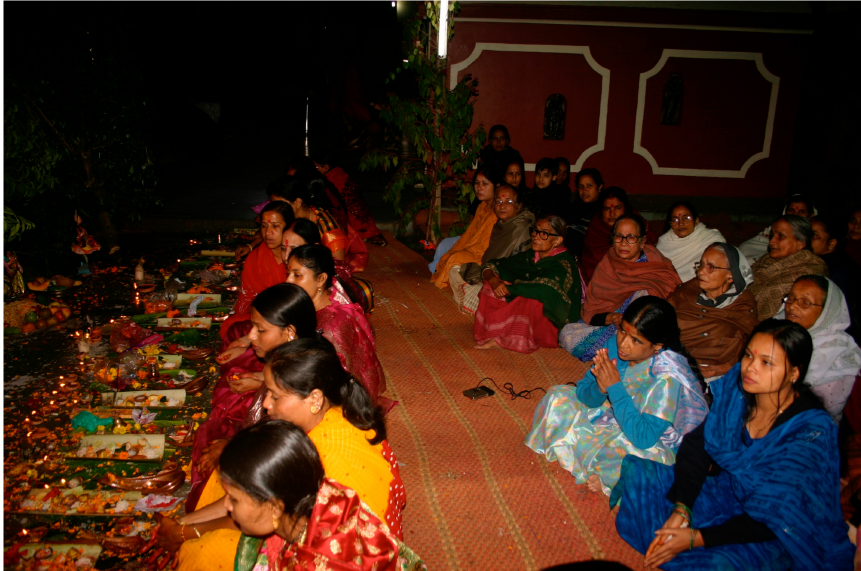
Figure 3. The performers and audience during K¯aty¯ayan¯ı